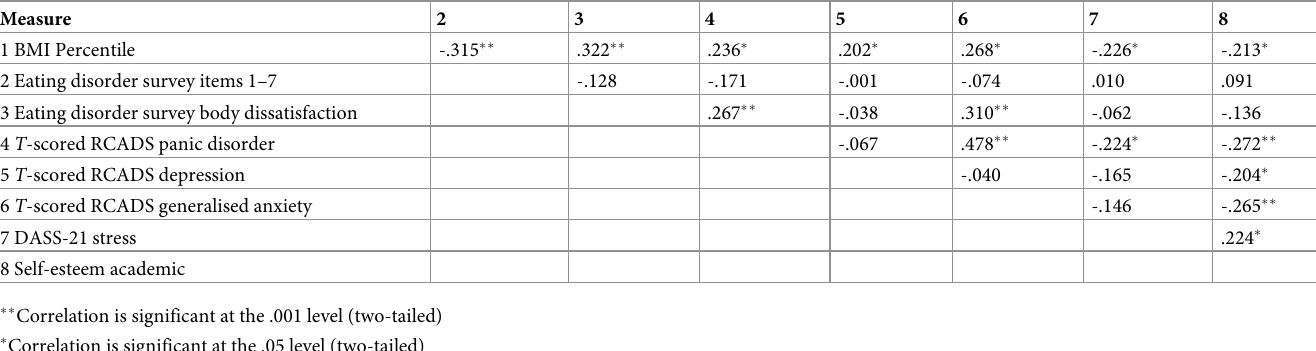
Table 3. Pearson’s correlations for diabetes group bmi percentile with other study variables. Measure